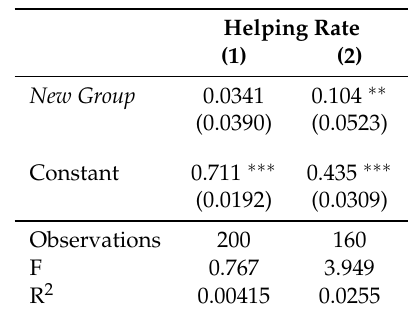
Table A10. Linear regressions: helping of new group members.